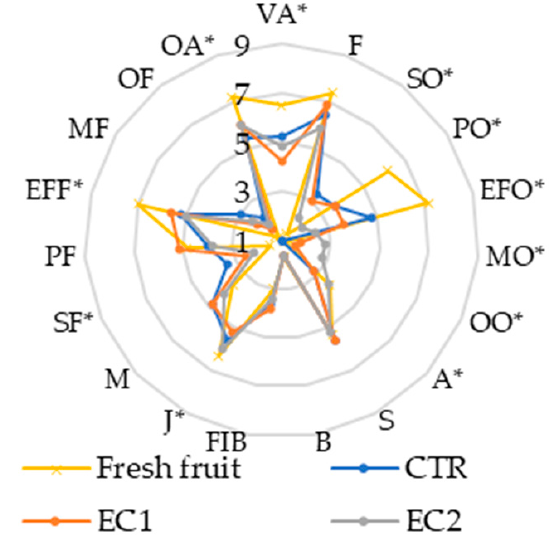
Figure 10. Sensory analyses of fresh-cut mango cubes after seven and nine days of cold storage. Descriptors: visual appearance (VA), firmness (F), sea odour (SO), peach odour (PO), exotic fruit odour (EFO), medicinal odour (MO), off-odour (OO), acidity (A), sweetness (J), bitterness (B), fi- brousness (FIB), juiciness (J), mellowness (M), sea flavour (SF), peach flavour (PF), exotic fruit fla- vour (EFF), medicinal flavour (MF), off-flavour (OF), overall assessment (OA). Statistical differ- ences ( p < 0.05) were highlighted by * on the descriptors.